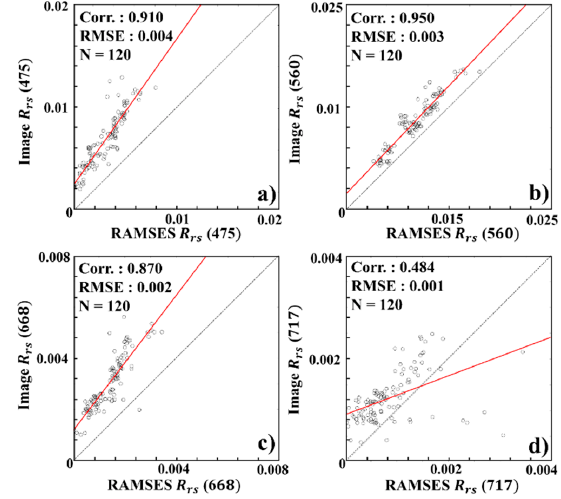
Figure 5. Extracted data of more than 95 % significance. Each subfigure is the two different R rs at 475 nm ( a ), 560 nm ( b ), 668 nm ( c ), 717 nm ( d ), and 840 nm ( e ). The x-axis is R rs of the RAMSES (RAMSES R rs ) and y-axis is R rs of the image (Image R rs ) value. The black dotted line indicates a one-to-one correspondence and the red solid line indicates the fitting curve between the two data.